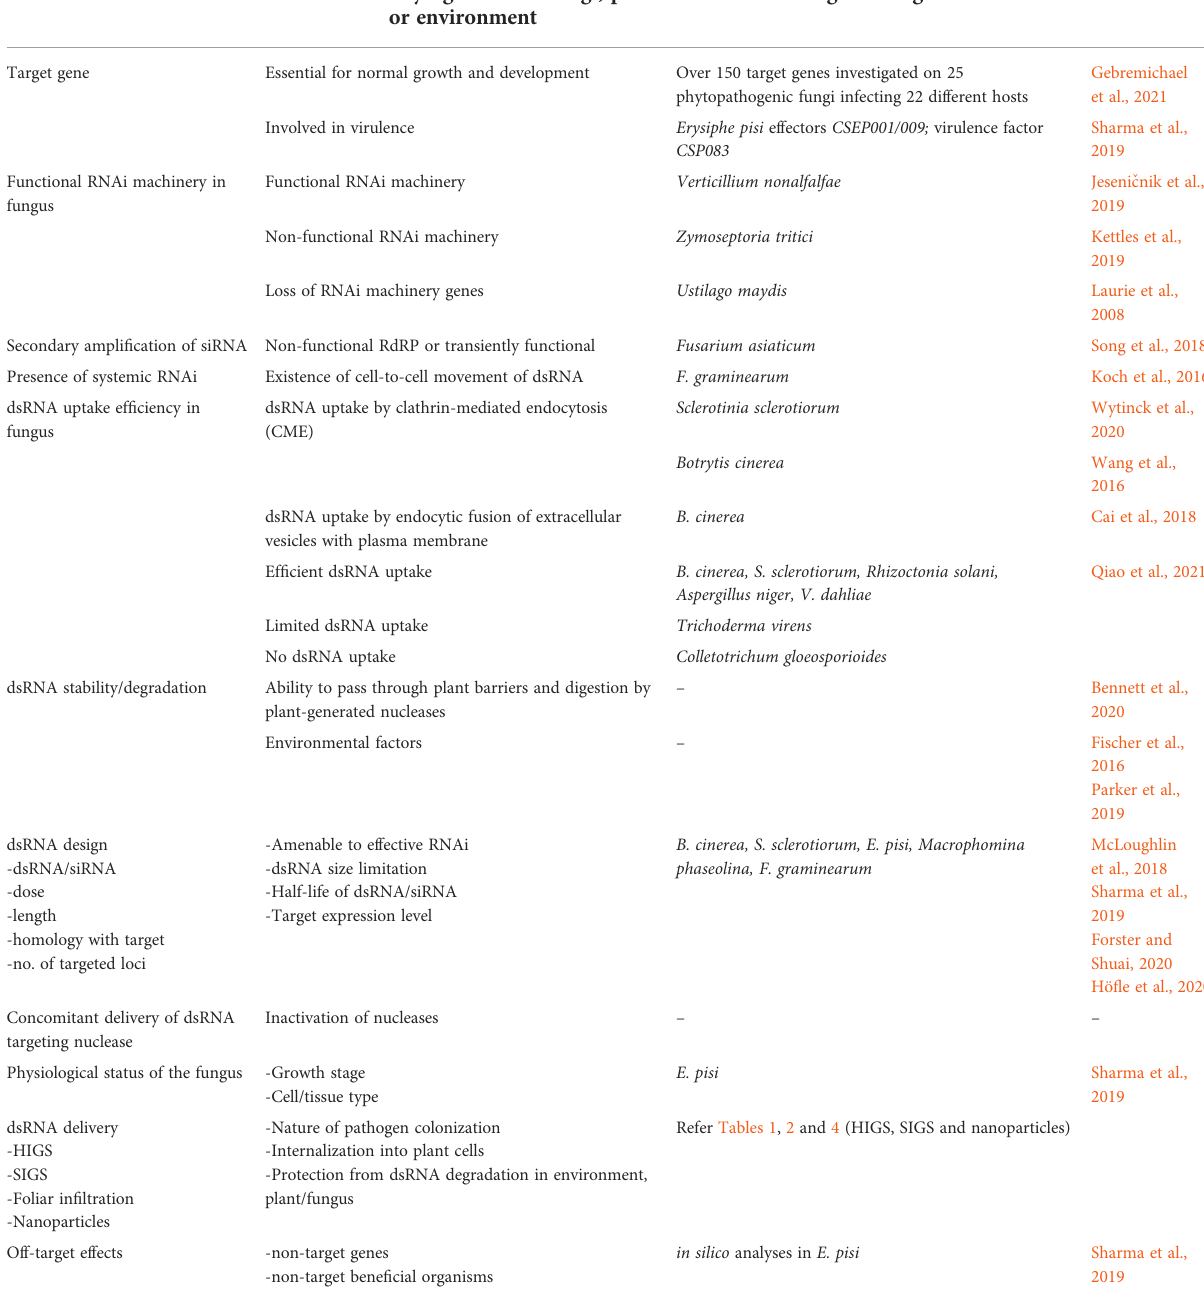
TABLE 3 List of factors in fl uencing dsRNA-mediated RNAi in phytopathogenic